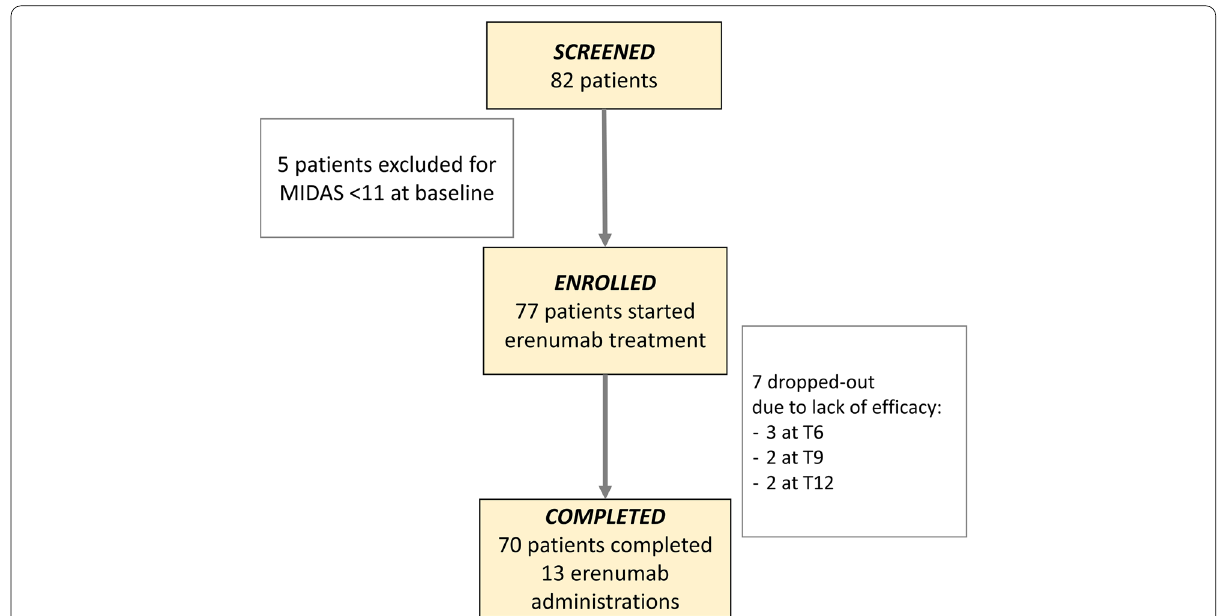
Fig. 1 Flowchart of enrolled patients. MIDAS: MIgraine Disability ASsessment. T6, T9, T12: follow-up visits at six, nine, and twelve months after first erenumab